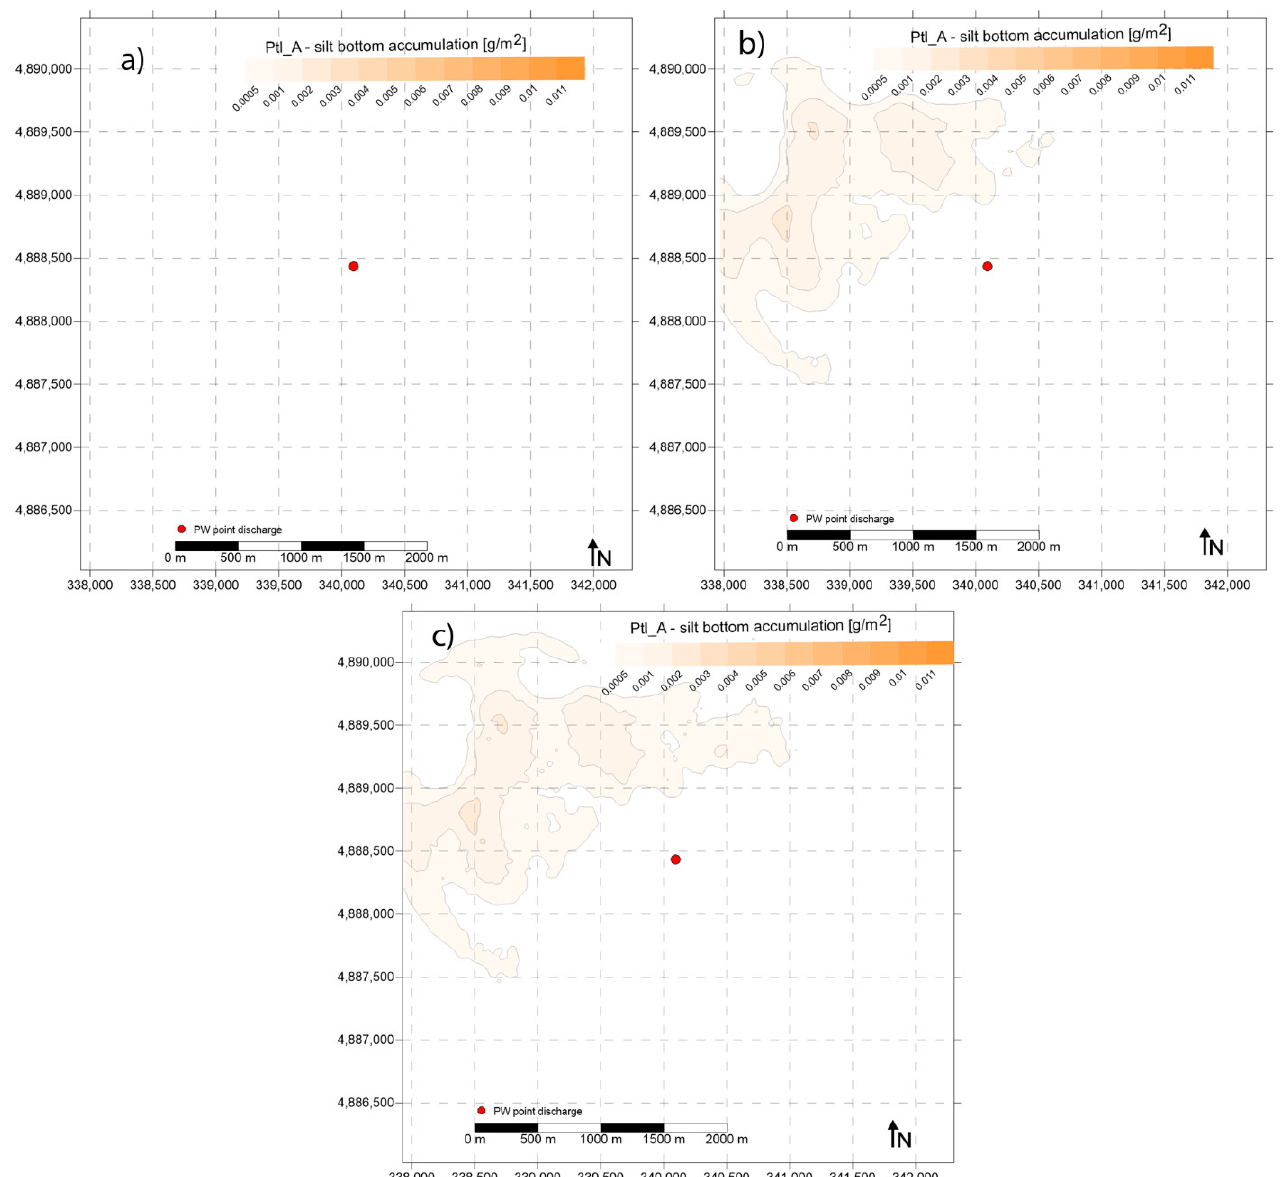
Figure 11. Map (WGS 84 UTM 33N) of silt bottom accumulation ( a ) after 10 days, ( b ) after 20 days, and ( c ) after one month as result by MIKE 3 PT module output for Plt A (red dot).